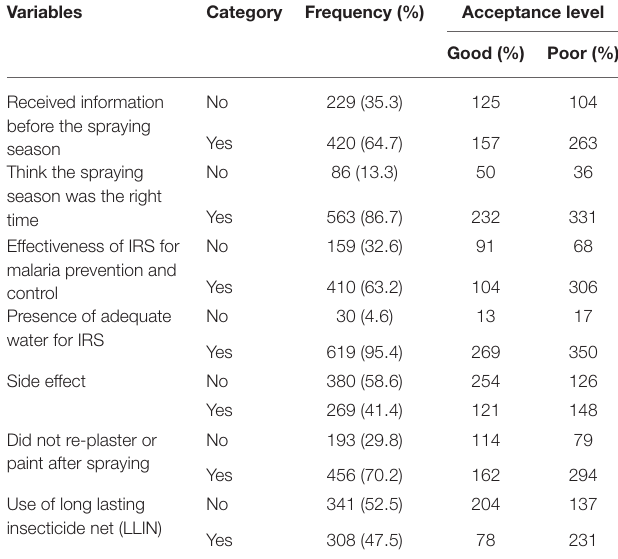
TABLE 2 | Knowledge of the study participants about malaria, North Eastern Ethiopia, 2021. Variable